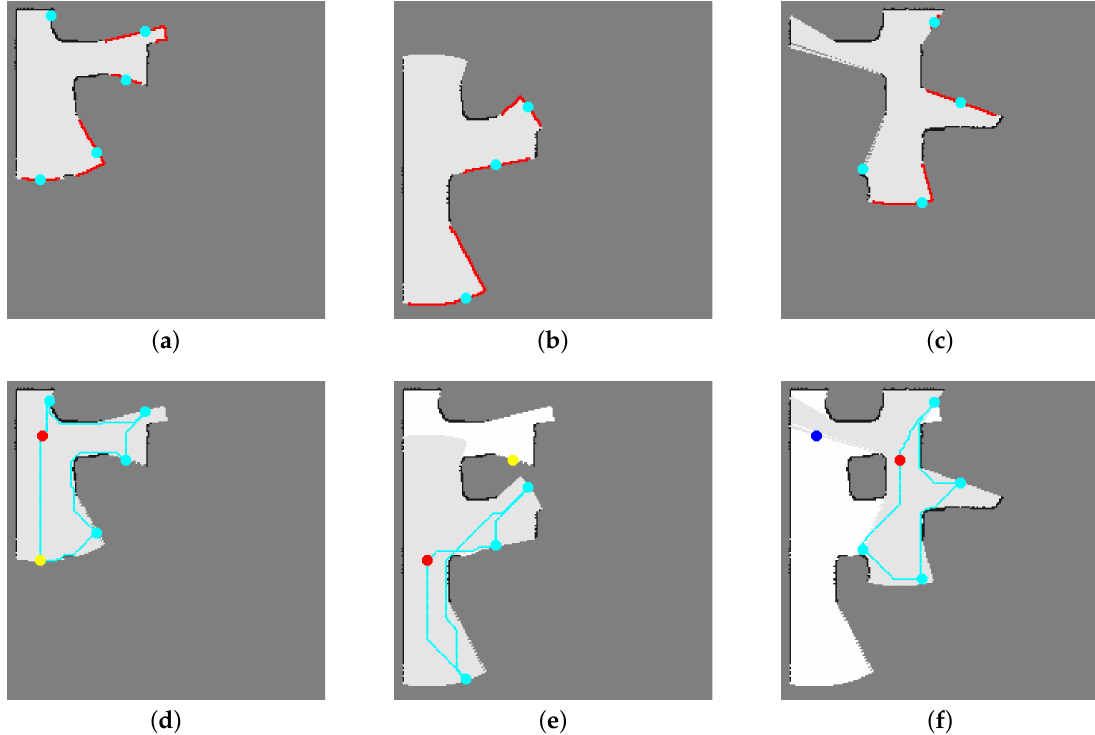
Figure 2. Examples of frontier segmentation. Medium gray indicates unknown cells; black indicates occupied cells; very light gray indicates empty cells; red stars are detected frontier cells; cyan dots are representative nodes; red dots are current nodes; yellow dots are unexplored next targets; the blue dot is the next explored target; cyan lines show the solution to the traveling salesman problem (TSP) for the current node and its child nodes: ( a ) Local map constructed at the root node ( b ) local map constructed at the root node’s first child node ( c ) local map constructed at the root node’s third child node ( d ). A single map is used at the root node to discriminate real frontiers. ( e ) The local maps of the current and parent nodes are merged. The previous node is the parent node. The root/parent node’s second child node is not at the frontier area in the merged map, and is eliminated from the exploration target list to obtain a new observation. ( f ) The local maps of the current, parent, and previous nodes are merged. The previous node is the sibling